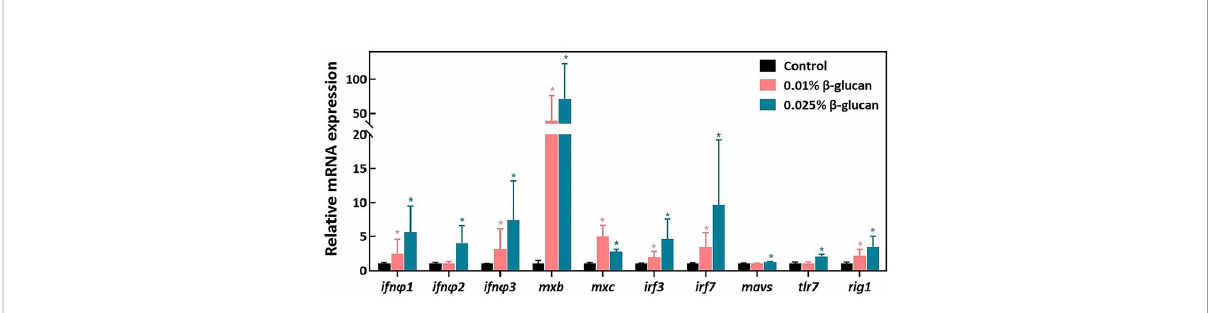
FIGURE 2 Relative mRNA expression of genes related to antiviral innate immune response in the spleen of zebra fi sh four days after SVCV challenge (n = 6). The expression of genes was expressed as fold of control group. Values represent the means ± SEM.* P <